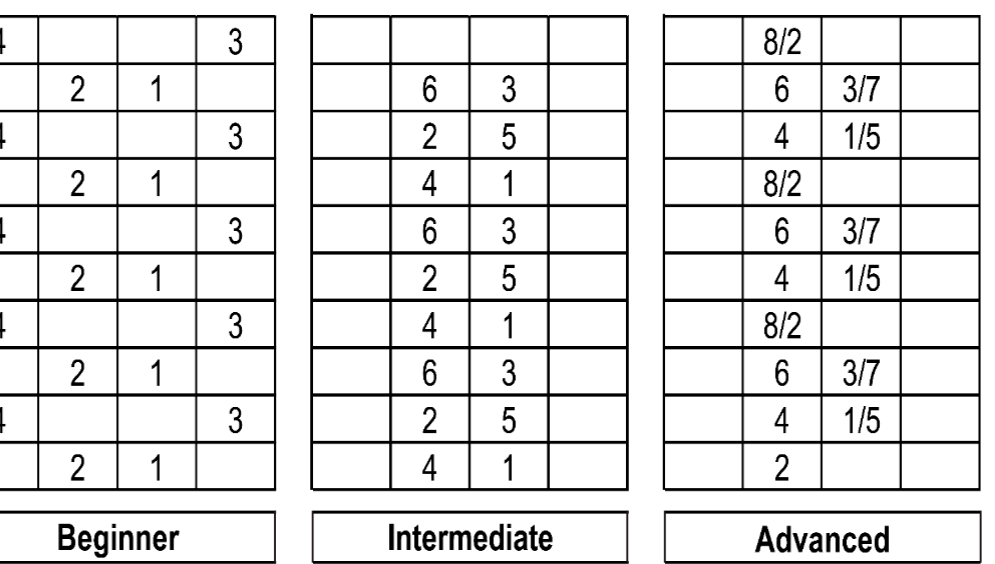
Figure 1. Examples of square-stepping exercise patterns.